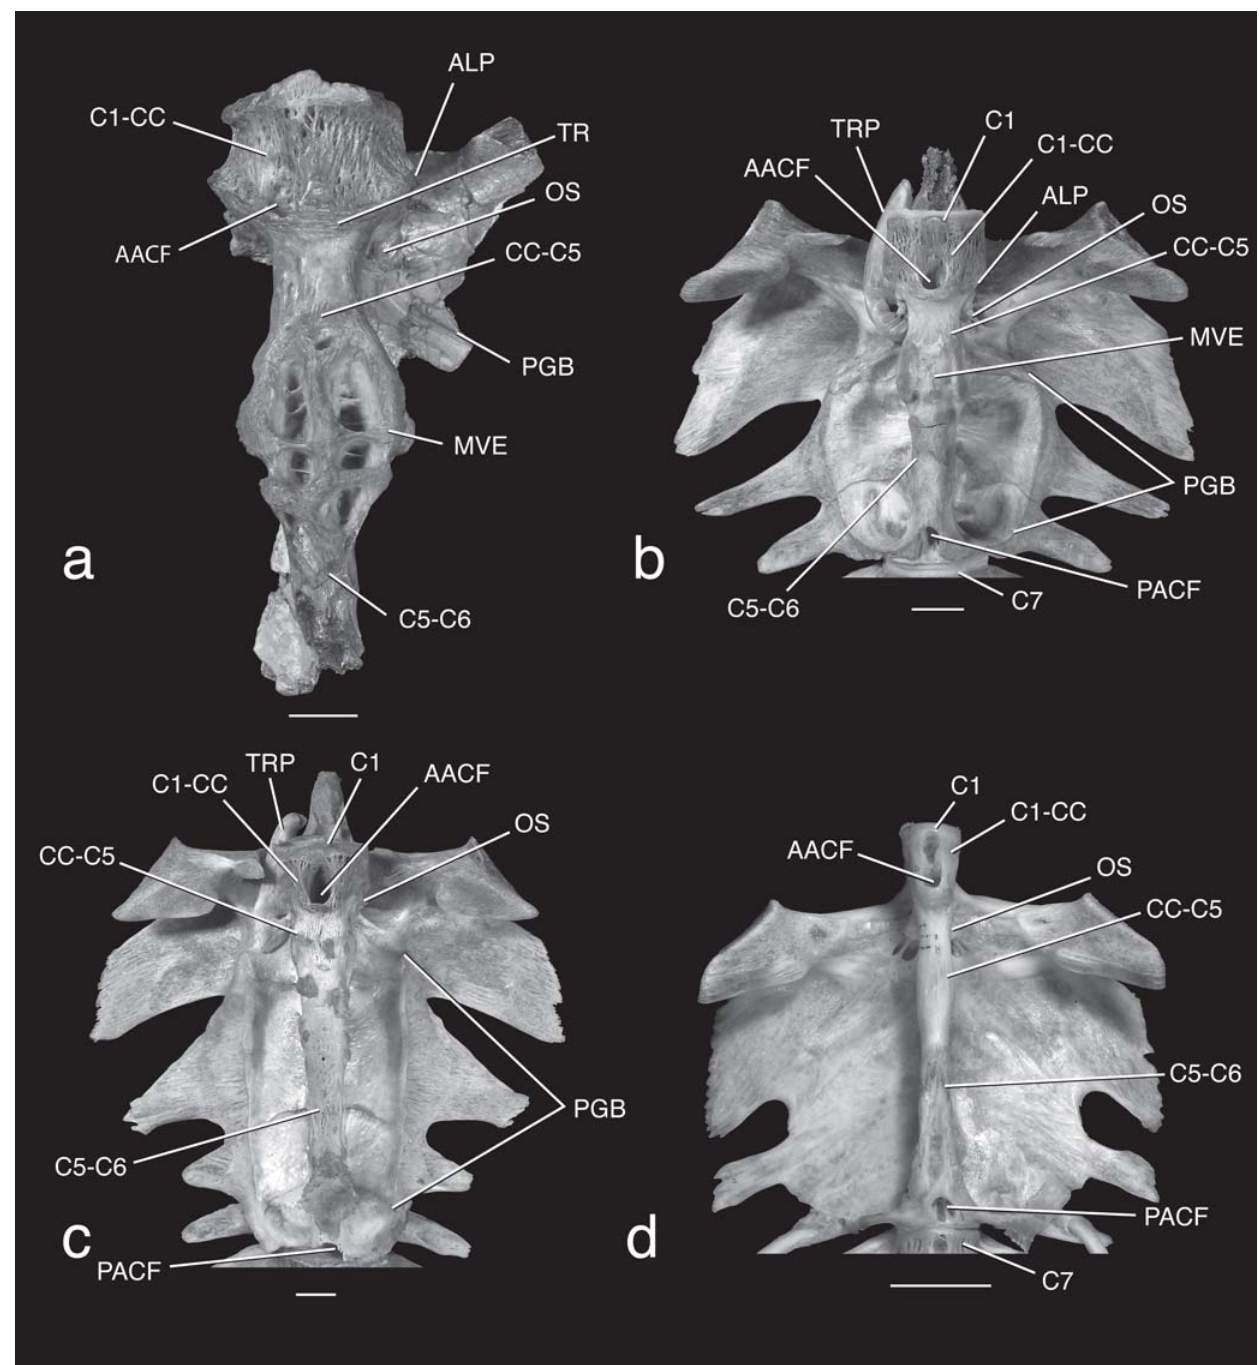
Fig. 2. Weberian complexes in ventral view of the fossil and modern Brachyplatystoma species, a, B. promagdalena , IGM183062, b, B. filamentosum , DU F1052, c, B. rousseauxii , DU F1078, d, B. vaillantii , DU F1034. Scale bars equal to 1 cm. Abbreviations as in Fig. 1 plus: AACF, aortic canal anterior foramen; C1, first centrum; C7, seventh centrum; C5-C6, fifth centrum- sixth centrum joint; CC-C5, compound centrum- fifth centrum joint; OS, os suspensorium ; PACF, aortic canal posterior foramen; PGB, gas bladder platform; TR, transverse ridge;